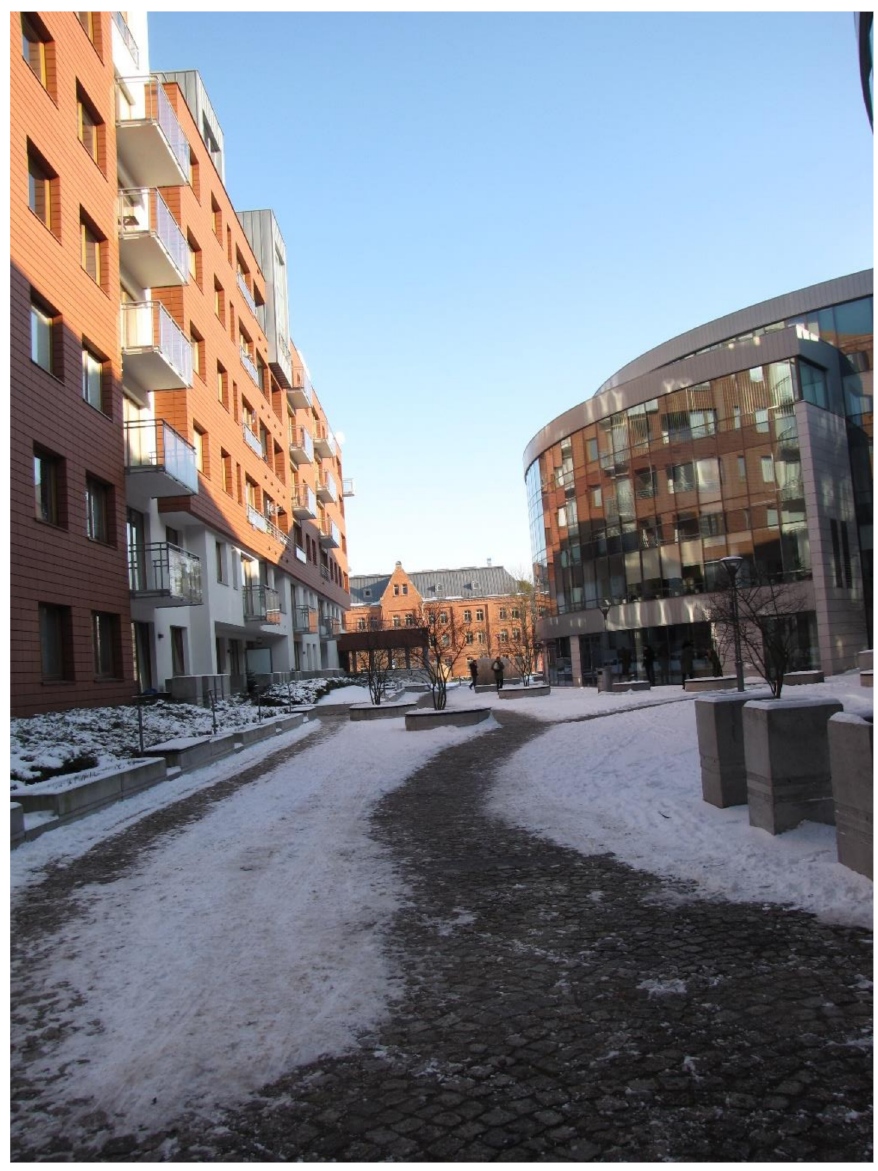
Figure 15. The preserved part of Wrzeszcz barracks as seen from the redeveloped residential district (photo by M.